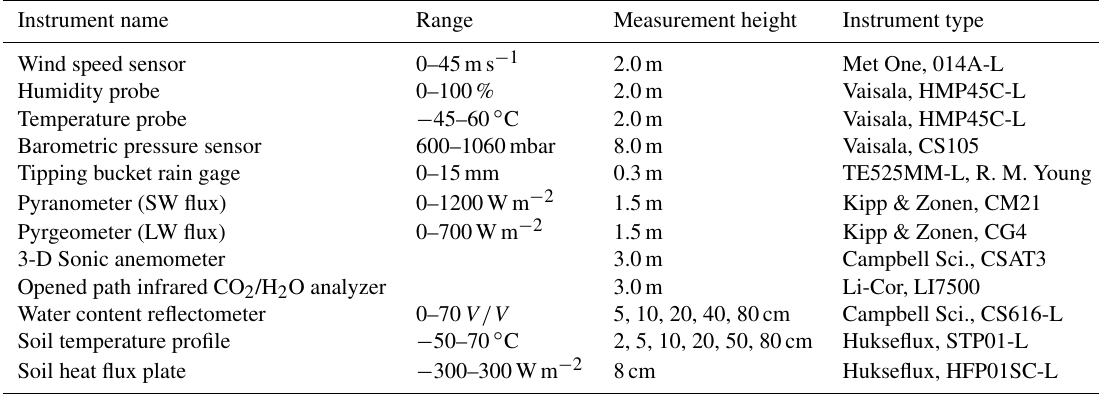
Table 1. Instruments, measurement ranges, measurement heights, and instrument